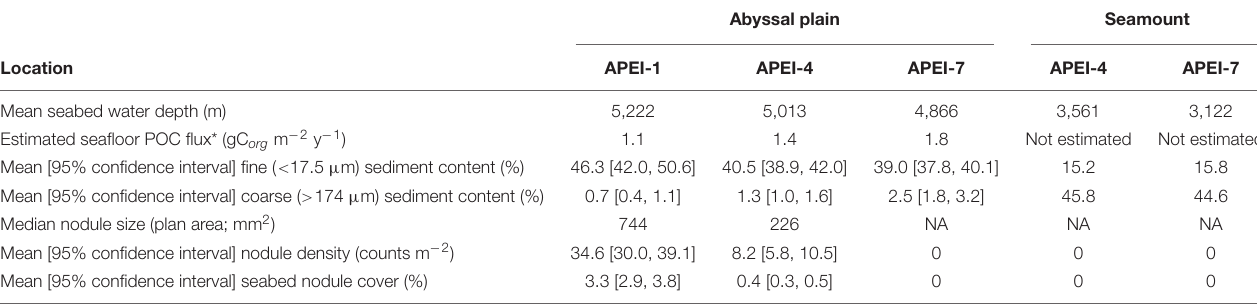
TABLE 2 | Environmental characteristics of the study areas by APEI and habitat type.